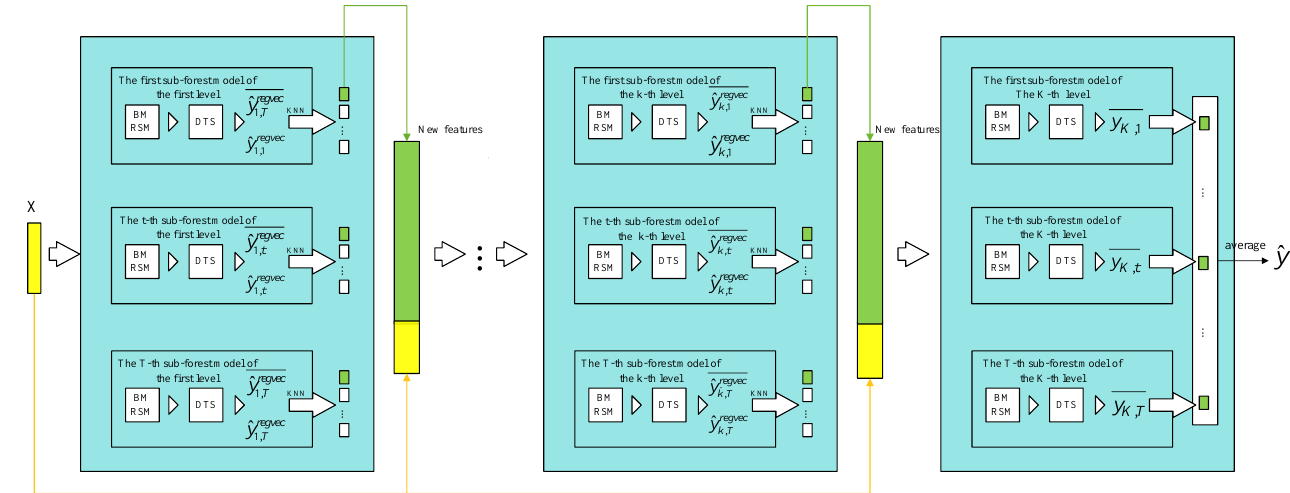
Figure 4. Diagram of cascade forest module structure.